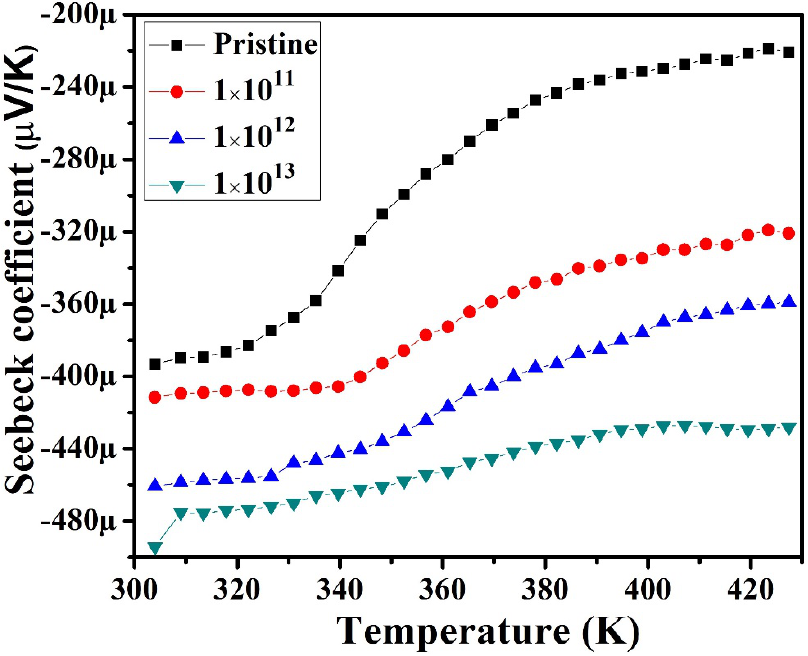
Figure 5. Temperature − dependent Seebeck coefficients of pristine and irradiated In 2 (Te 0.98 Se 0.02 ) 3